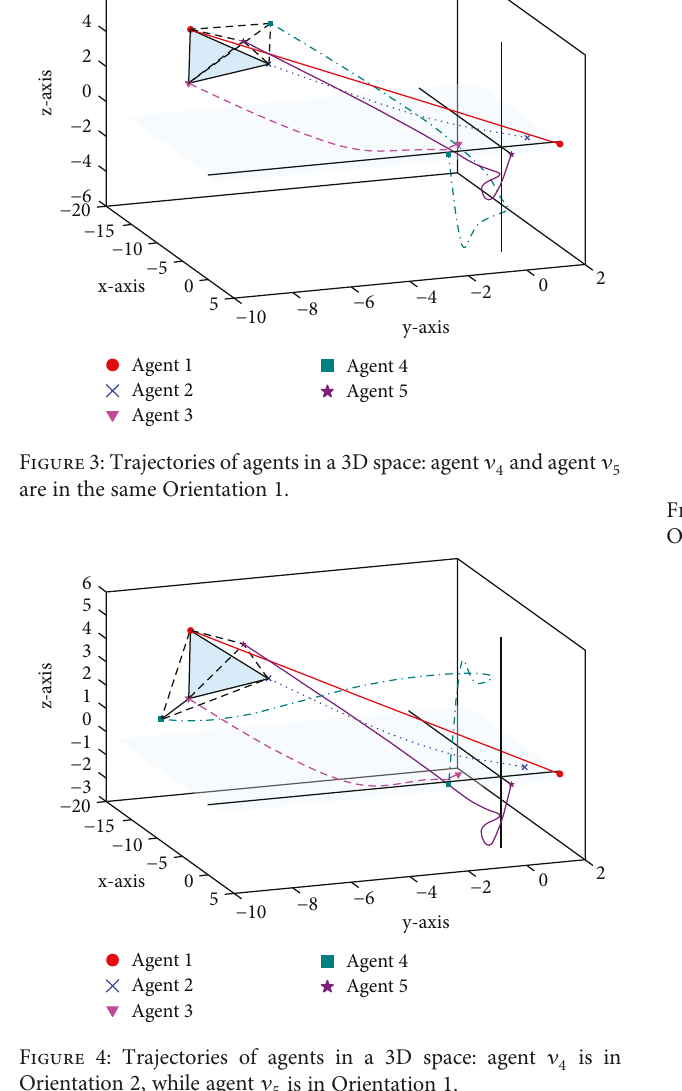
4 is in Figure 6: Distance errors: agent ν ν 5 is in Orientation